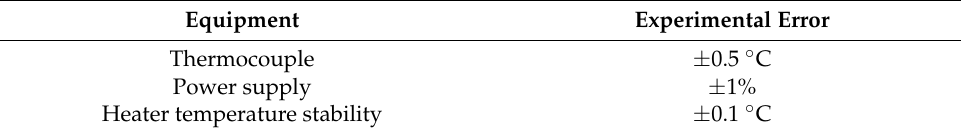
Table 1. Experimental